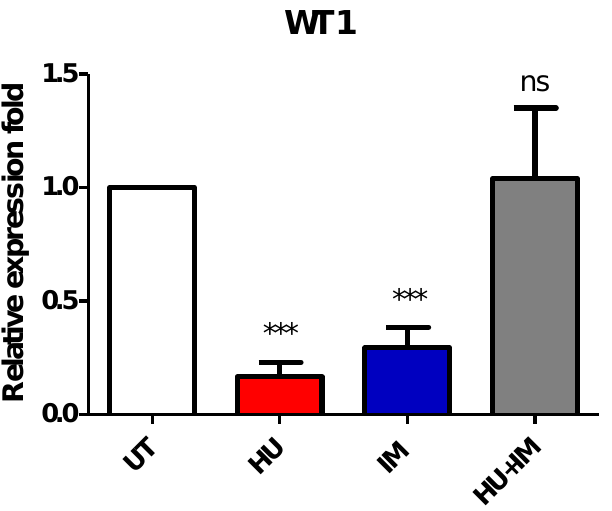
Figure 5. Relative expression of WT1 to β -actin gene. Two-tailed paired t -test showed a significant statistical difference between UT vs. HU and UT vs. IM (*** p < 0.005). (mean ± SEM; n = 2).